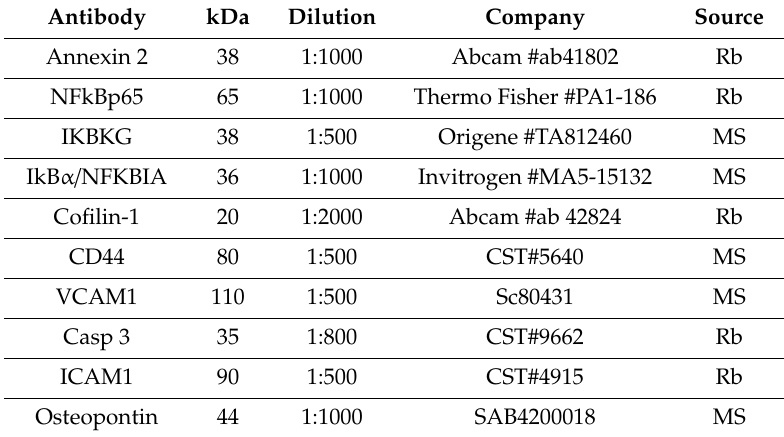
Table 2. List of the names, sources, companies, molecular weight and dilutions of all the antibodies that were used for Western blots. Antibody kDa Dilution Company